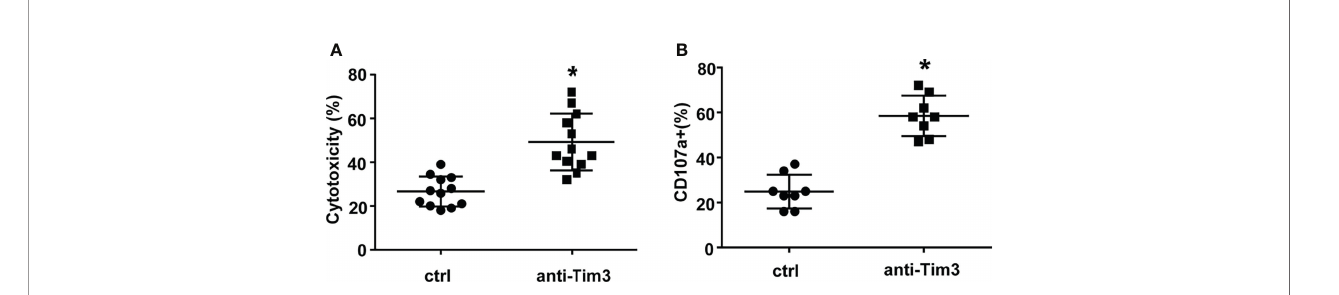
FIGURE 5 | Tim-3 blockade enhanced NK cell-mediated natural cytotoxicity against primary human MM cells. Human primary MM cells from 12 relapsed/refractory MM patients and 11 control donors were used as target (T) cells. CD138 + MM cells were sorted by immunomagnetic separation from the bone marrow of MM patients. exNK cells were used as effector (E) cells and the E:T ratios was 1:1. Cytotoxicity activity of NK cells was tested by PKH26/Annexin-V stain. * P < 0.05 versus control NK cells. Cytotoxicity activity (A) and CD107a surface expression (B) of NK cells were tested.